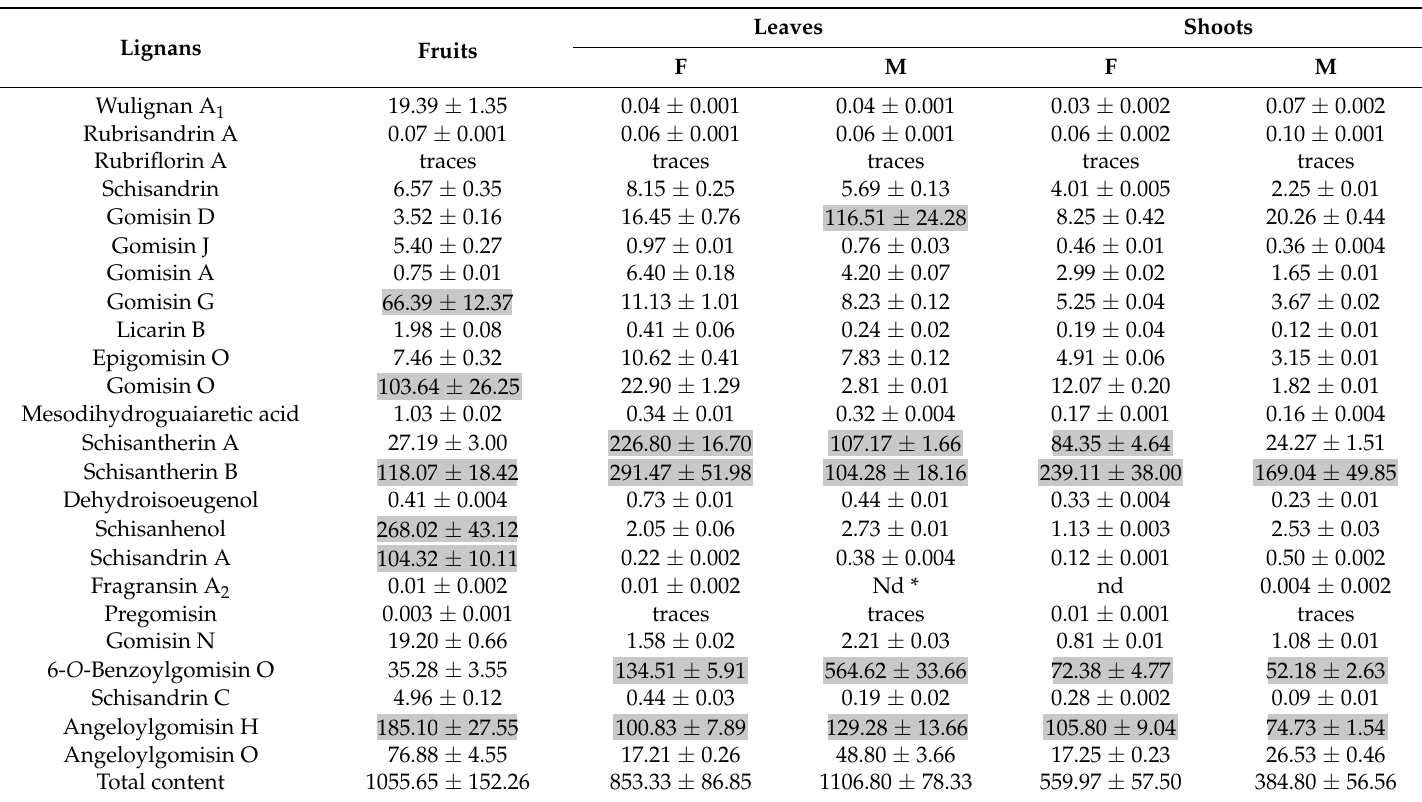
Shaded parts indicates the highest quantities of given compounds. *—nd—not